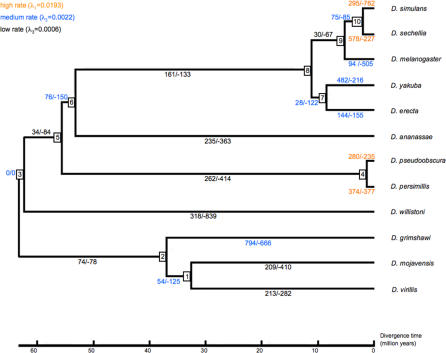
Gene Family Evolution in Drosophila
On each branch of the tree the number of gene gains/losses is given. The colors of the numbers denote the estimated rate of gene gain and loss. Numbers in boxes are identifiers for internal branches of the phylogeny.